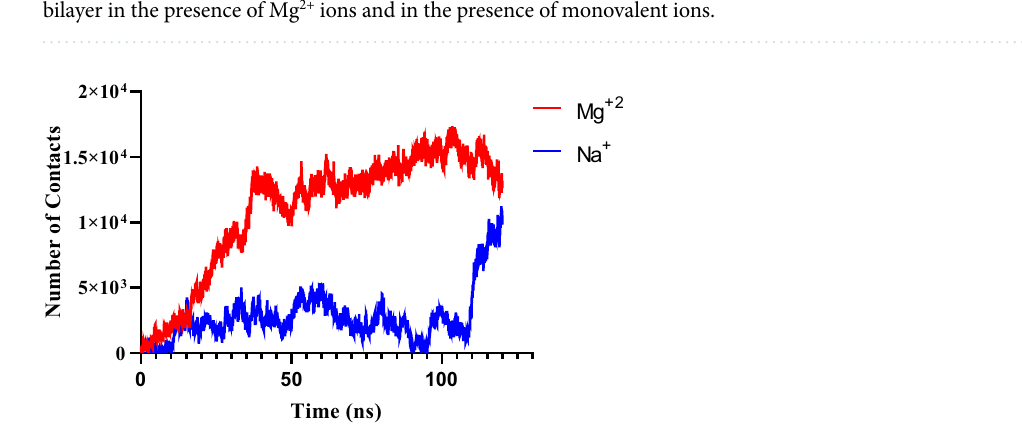
Figure 9. The number of contacts between siRNA-cholesterol-conjugate system–lipid